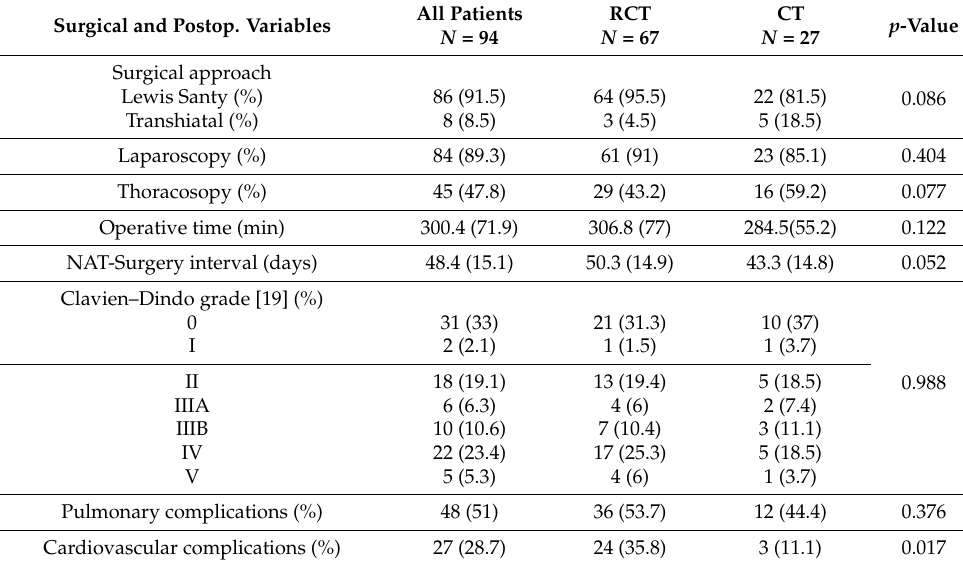
Table 2. Surgical characteristics and postoperative outcomes for all patients. Surgical and Postop.